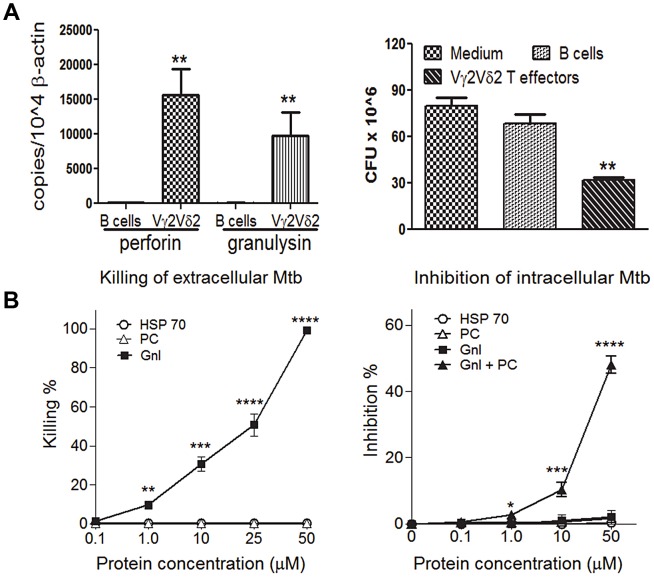
Vγ2Vδ2 T effector cells and macaque granulysin/perforin restricted Mtb growth.(a). Shown on left are real time quantitative PCR data for mRNA expression levels of perforin and granulysin expressed by macaque Vγ2Vδ2 T effector cells capable of restricting intracellular Mtb growth. The quantitation was done using the methods as we previously described [40]. Data are means with SEM from phosphoantigen-activated Vγ2Vδ2 T effector cells from 3 Mtb-infected macaques in 2 independent experiments. Control B cells were purified using CD20 mAb and immunemagnetic beads [29]. Right panel shows that co-culturing of Mtb-infected monocytes with Vγ2Vδ2 T effector cells expressing perforin/granulysin led to reduction in CFU bacterial counts. (b). Graph curves show that recombinant granulysin(Gnl), but not perforin(PC), killed extracellular Mtb (left); Gnl+PC inhibited intracellular Mtb growth(right). Data are the killing or inhibiting percentage of extracellular or intracellular Mtb CFUs relative to Mtb CFUs in medium-only control(see Methods). Data are means derived from Mtb-infected monocytes from three macaques in 3 experiments. ** p<0.001; ***p<0.0001; ****p<0.00001, by student t test.